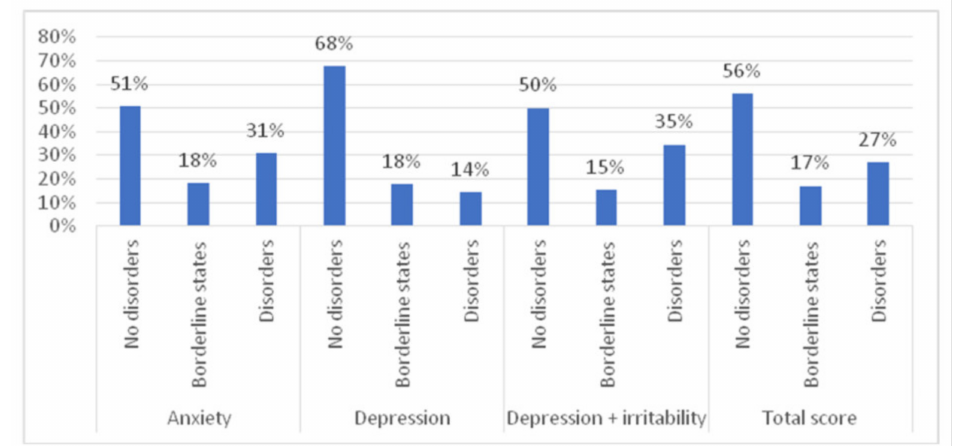
Figure 1. HADS-M scores in the study population of